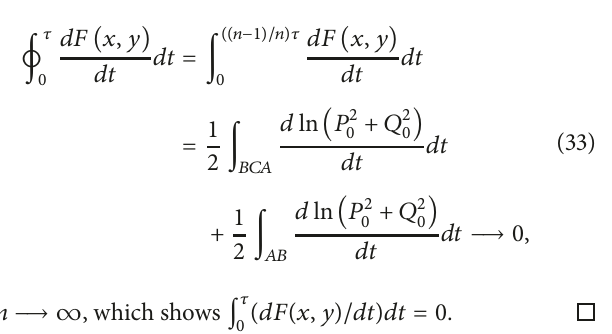
Suppose Γ 𝑛 ̂𝐵𝐶𝐴 denotes the curve of system (32) from the point 𝐵(𝑥 𝐵 , 𝑦 𝐵 ) to the point 𝐴(𝑥 𝐴 , 𝑦 𝐴 ) , where Γ 𝑛 ̂𝐵𝐶𝐴 (0) = 𝐵 , Γ 𝑛 (((𝑛 − 1)/𝑛)𝜏) = 𝐴 . Γ 𝑛 ̂𝐵𝐶𝐴 𝐴𝐵 denotes the line segment Equation of the line segment 𝐴𝐵 is 𝑦 = ((𝑦 𝐴 − 𝑦 𝐵 )/(𝑥 𝐴 − 𝑥 ))(𝑥 − 𝑥 ) + 𝑦 𝑥 ≤ 𝑥 ≤ 𝑥 . Obviously, system (32) is the 𝐵 𝐴 𝐴 , 𝐵 𝐴 square approximation of system (6), which implies Γ 𝑛 󳨀→ Γ as 𝑡 󳨀→ ∞.